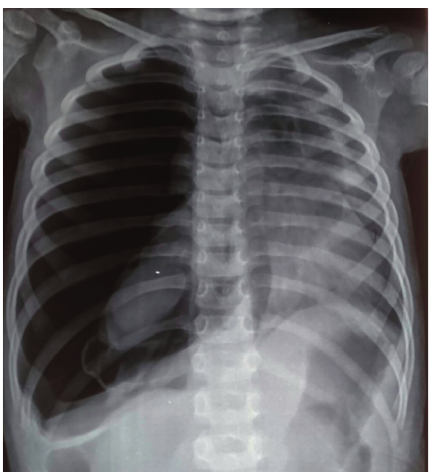
Figure 1: Chest X-ray showing the presence of a right-sided spontaneous pneumothorax with a midline shift to the